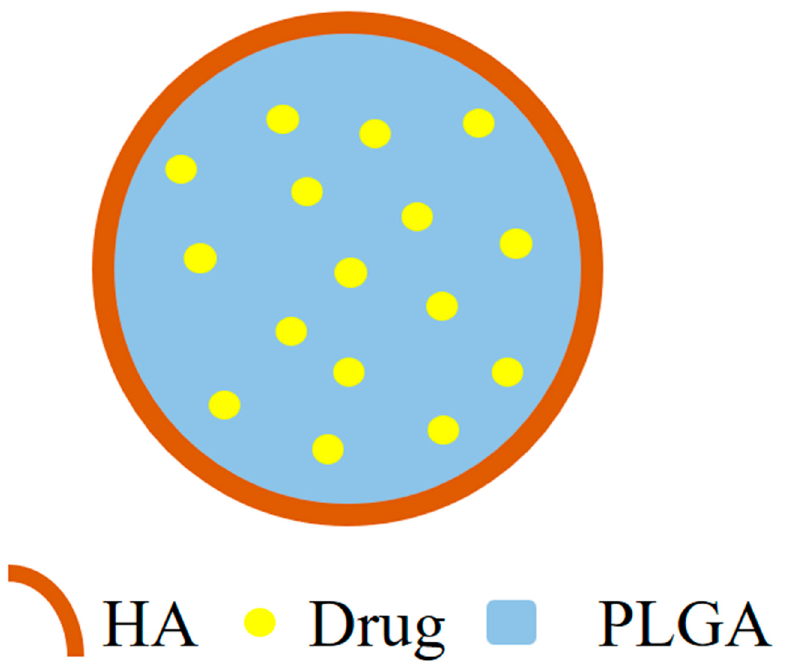
Figure 4 .A generalized structure of PLGA ‐ based nanohybrids. Figure 4. A generalized structure of PLGA-based